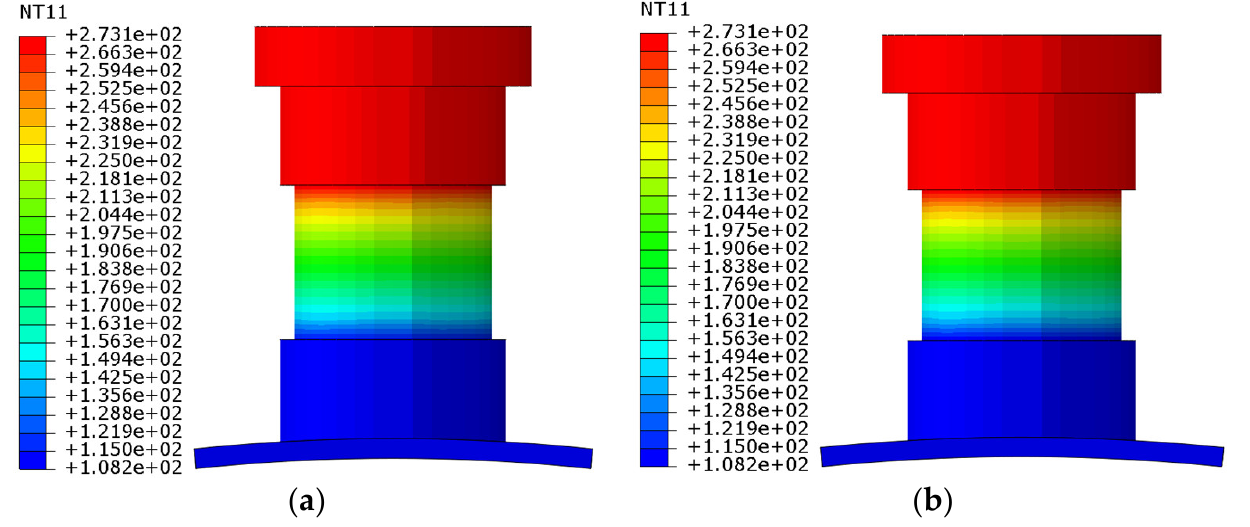
Figure 9. Temperature distribution of Bakelite support: ( a ) SUS304; ( b ) AL-5083-O.